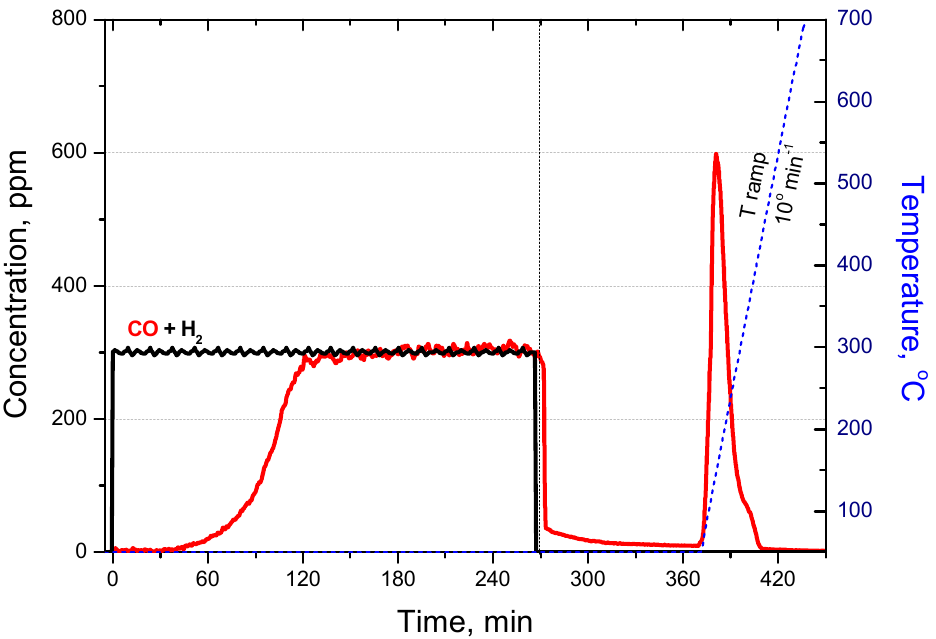
Figure 10. Breakthrough curves for binary gas mixture of CO + H 2 on 9.7CuZ23(SE) followed by subsequent TPD.